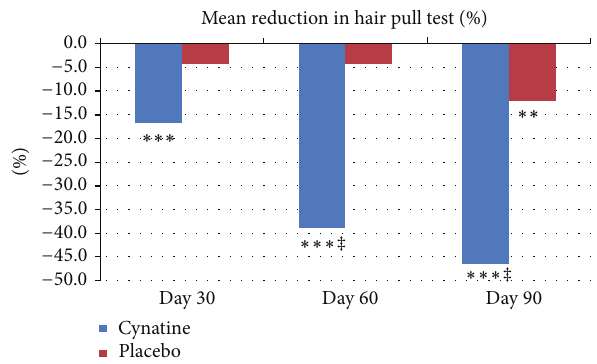
Figure 1: Mean percent reduction in hair pull test from baseline for placebo and Cynatine HNS. ∗∗ 𝑃 < 0.01 and ∗∗∗ 𝑃 < 0.001 within group to baseline; ‡ 𝑃 < 0.001 between groups to